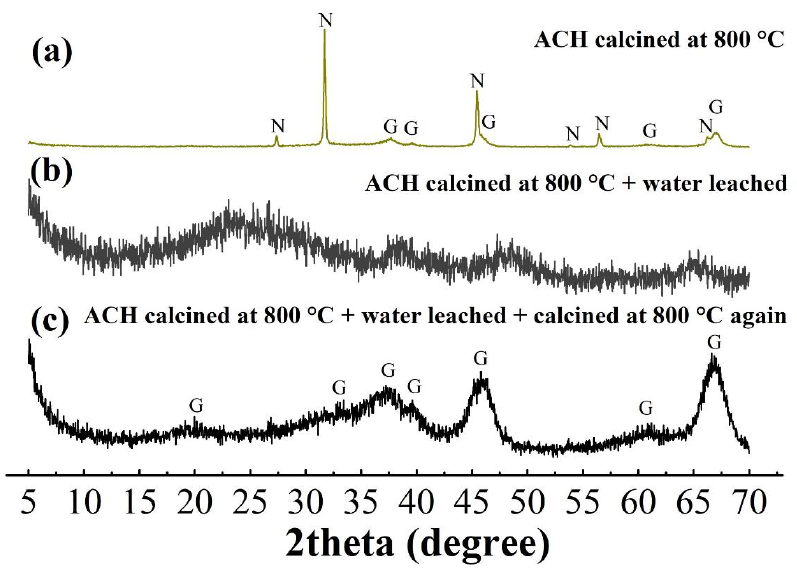
Figure 8. The XRD patterns of Al 2 O 3 were prepared using the calcination of the ACH sample at 800 °C for 60 min in the air without additional treatment ( a ), with subsequent water washing at 70 °C for 30 min ( b ), as well as with subsequent water washing at 25 °C for 15 min and the repeated calcination at 800 °C for 60 min ( c ); N — halite (NaCl), G —γ -Al 2 O 3 .